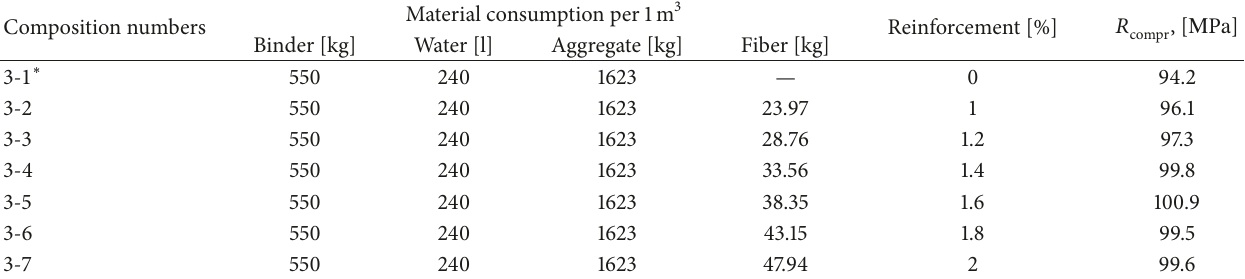
Table 9: Dependence of the strength of fiber-reinforced concrete on the percentage of reinforcement.